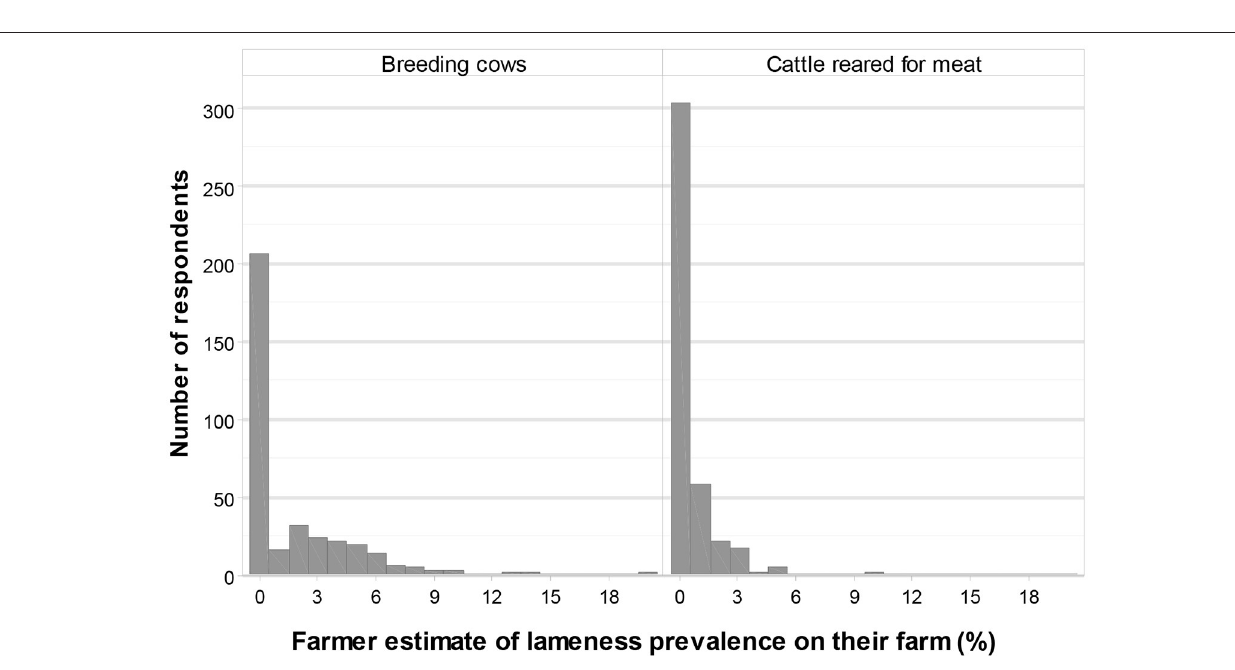
FIGURE 4 | Farmer-reported lameness prevalence on their own farm, subdivided by type of cattle: (i) breeding cows and pregnant heifers and (ii) cattle reared for meat, from weaning to slaughter (Q16, n = 359 and n =